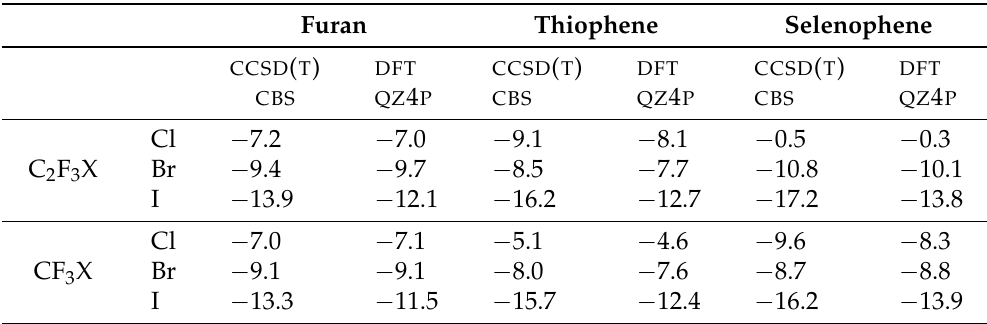
Table 1. Interaction energies (kJ/mol) for the parallel oriented complexes calculated with PBE0- dDsC/QZ4P and CCSD(T)-DLPNO/CBS.